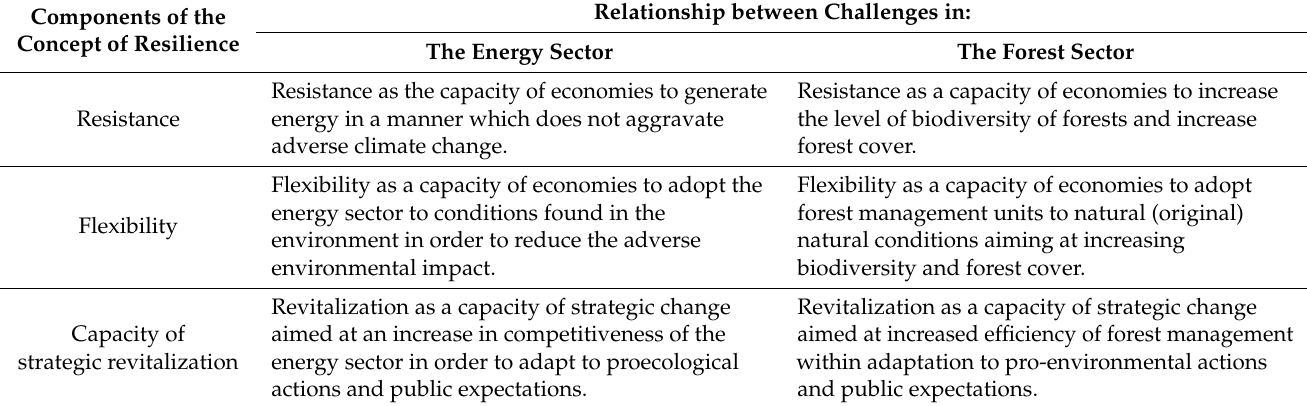
Table 4. Resilience and challenges to energy and forest